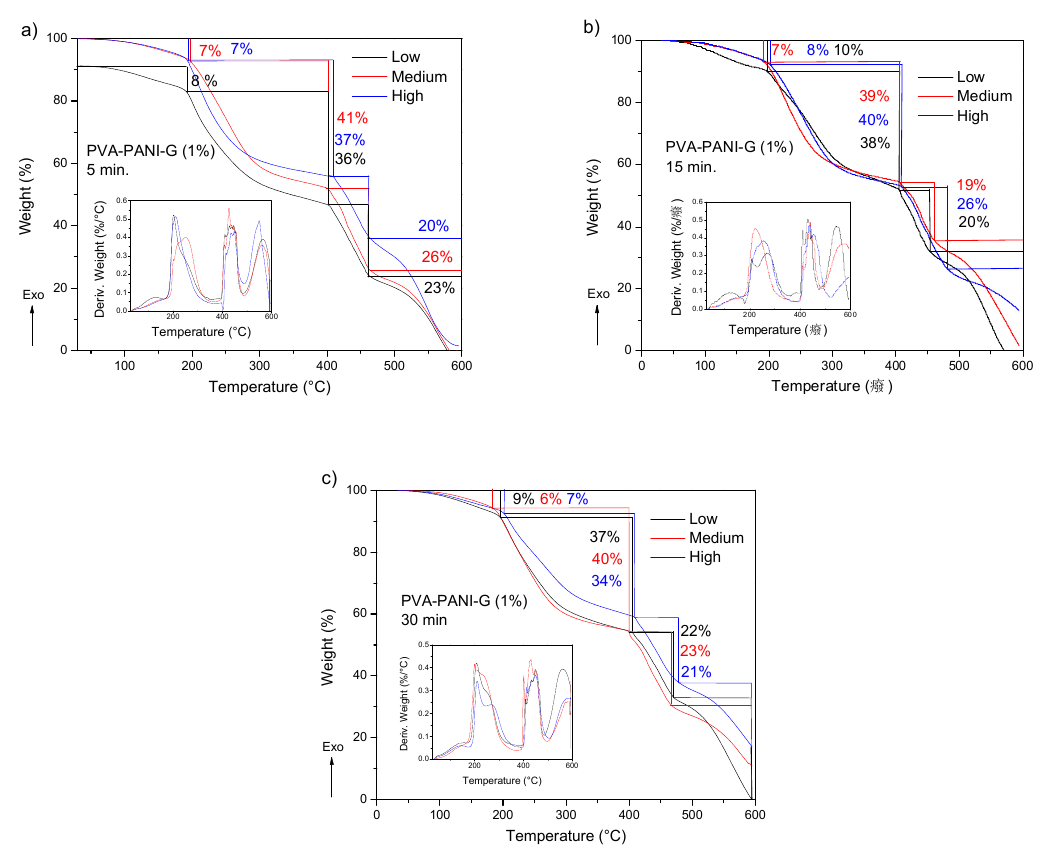
Figure 13. TGA and DTG thermograms of purified PVA–PANI-G gels, activated with 1% GA for ( a ) 5 min, ( b ) 15 min, and ( c ) 30 min.